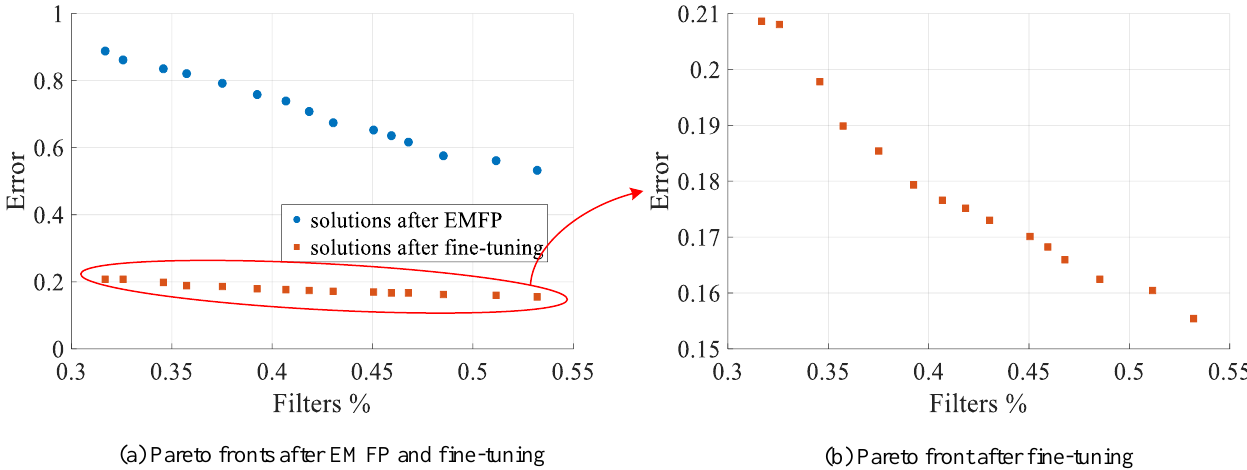
Figure 5. Pareto front of EMFP and scatter plot of fine-tuned solutions on